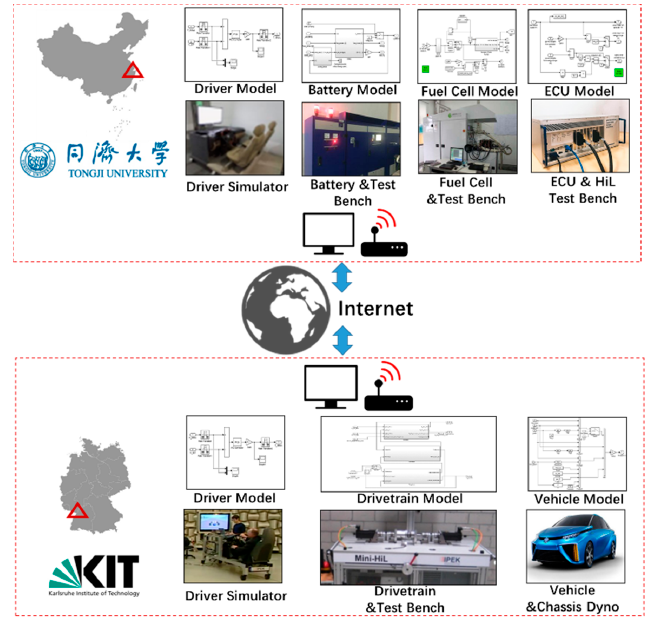
Figure 1. Structure of distributed test platform for fuel cell electric vehicle powertrain system.